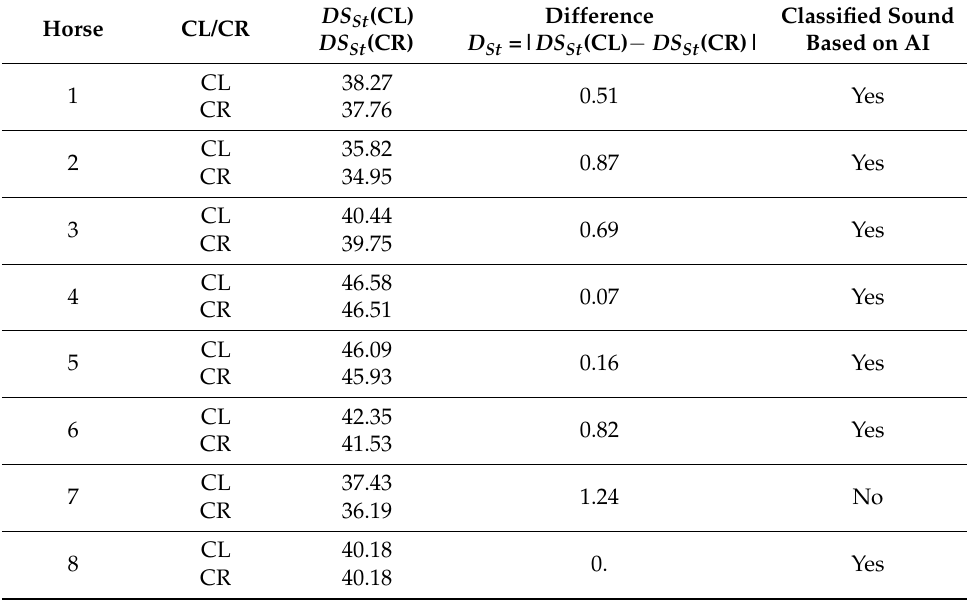
Table 2. Stifle reference point—Non-lame horses.